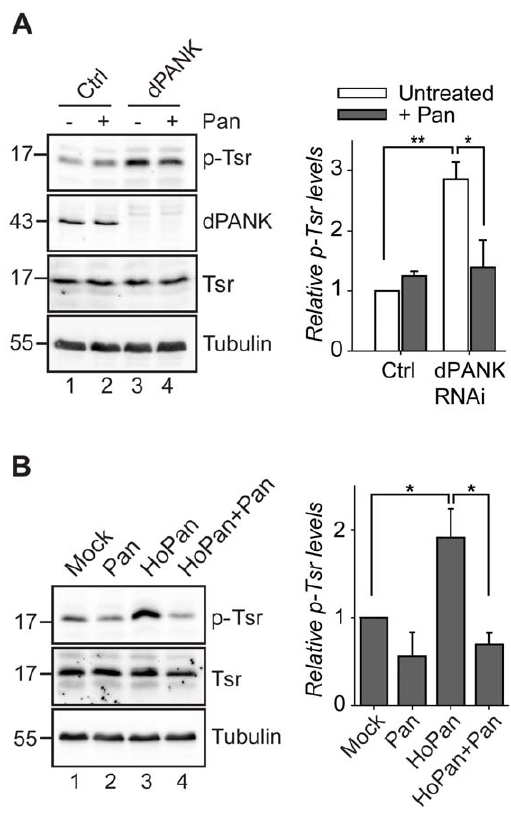
Figure 2. Inhibition of dPANK activity in S2 cells induces an increase in phospho-Twinstar levels. Immunoblots of whole cell extracts were incubated with an antibody against Tsr and p-Tsr. Tubulin was used as a loading control. ( A ) Cells were treated with control dsRNA or dsRNA to downregulate dPANK/Fbl protein levels and medium was supplemented with pantethine when indicated. The graph illustrates the quantified levels of p-Tsr relative to untreated control cells. ( B ) S2 cells were cultured in the presence of pantethine, HoPan or both compounds. The graph illustrates the quantified levels of p-Tsr relative to untreated control